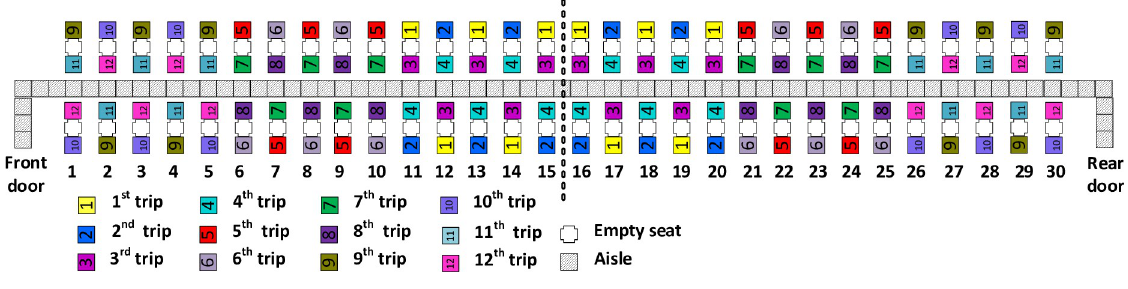
Fig 4. WilMA—Back-to-front boarding